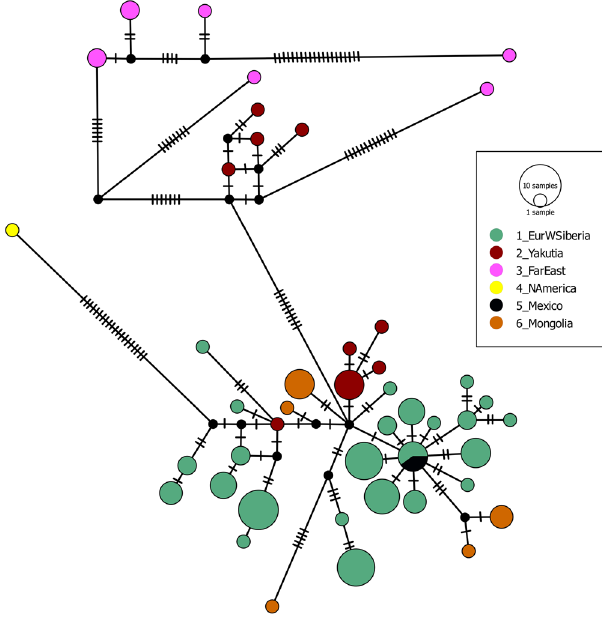
Figure 4. Median-joining ND2 haplotype network. Median vectors are indicated by small black circles. Number of mutations for each branch is